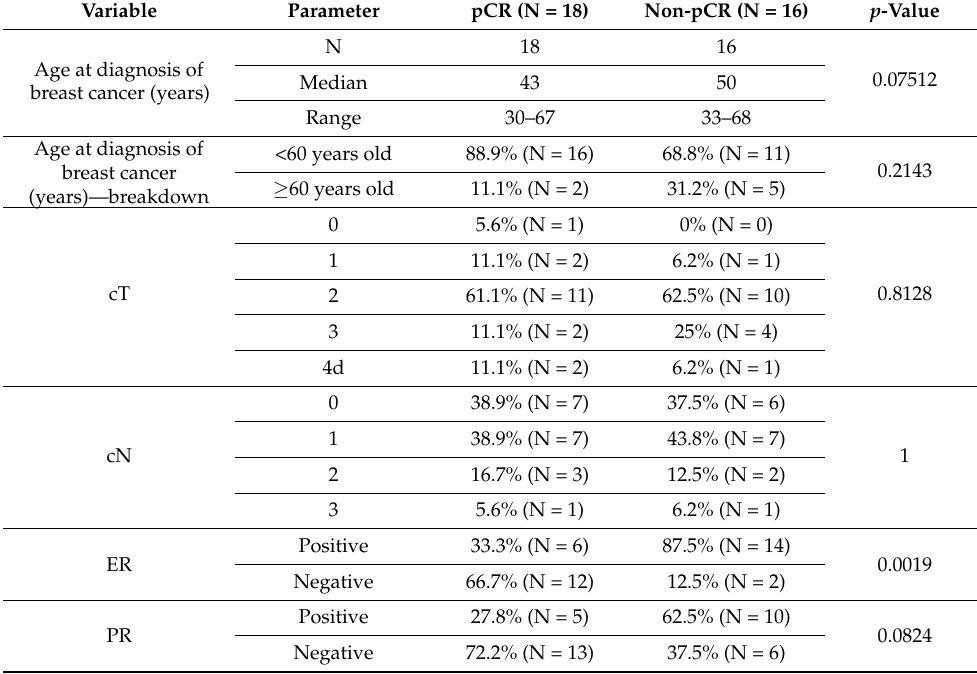
Table 4. Response to treatment depending on age, disease stage, and ER and PR status.